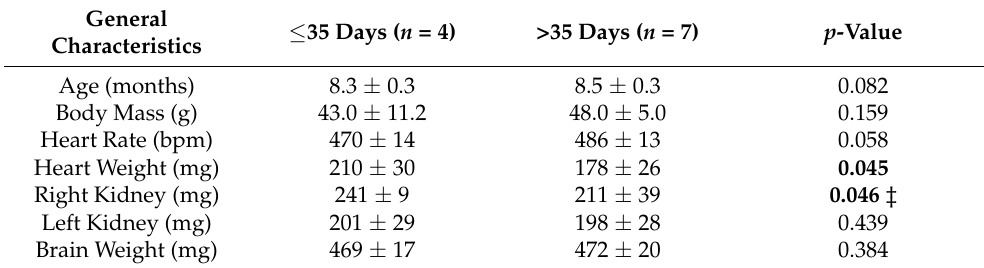
Table 2. General Characteristics of Mice used for data collection.